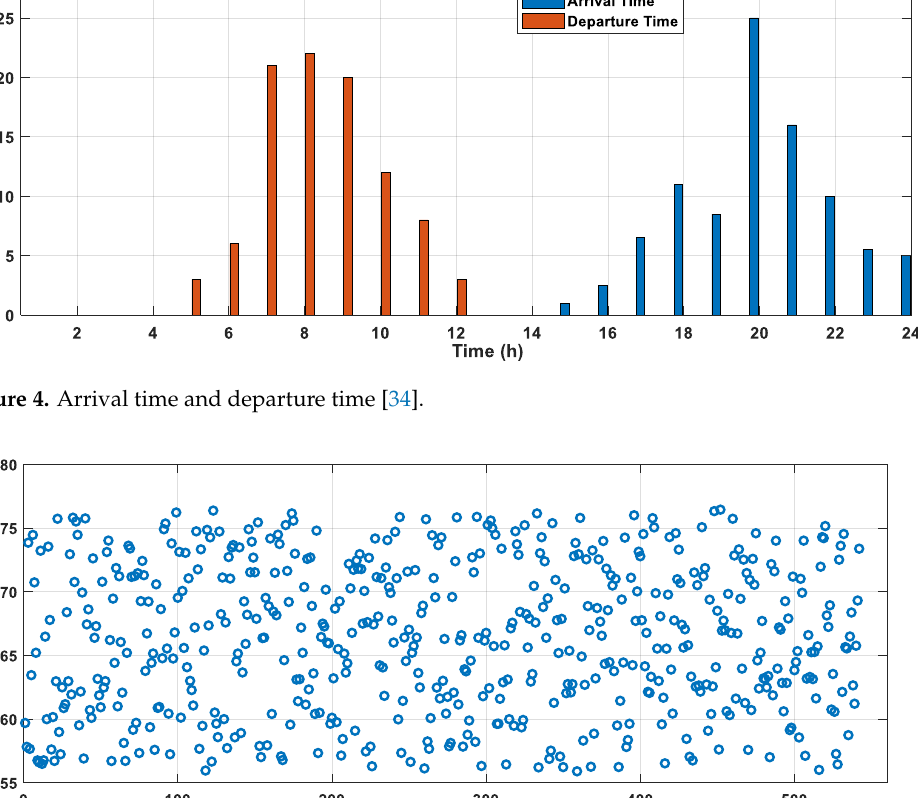
Table 4. Simulation parameters for PSO.